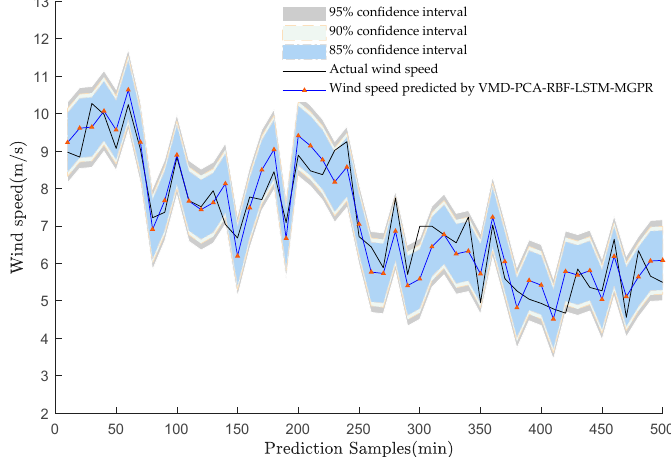
Figure 17. Interval and point prediction results of mixture Gaussian process regression (MGPR).